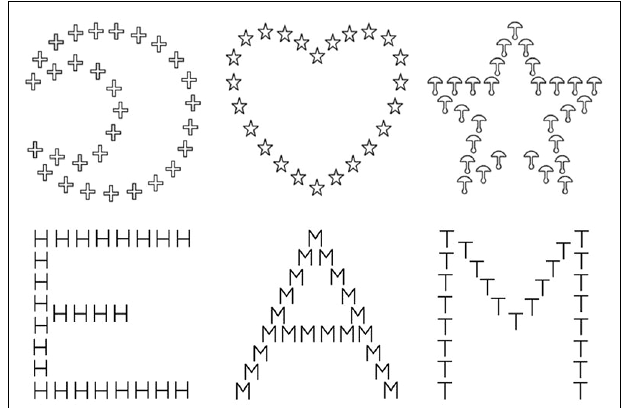
FIGURE 1 | Examples of figures used as object-based hierarchical stimuli with the star and the moon as the targets, and letter-based hierarchical stimuli with E and M as the target